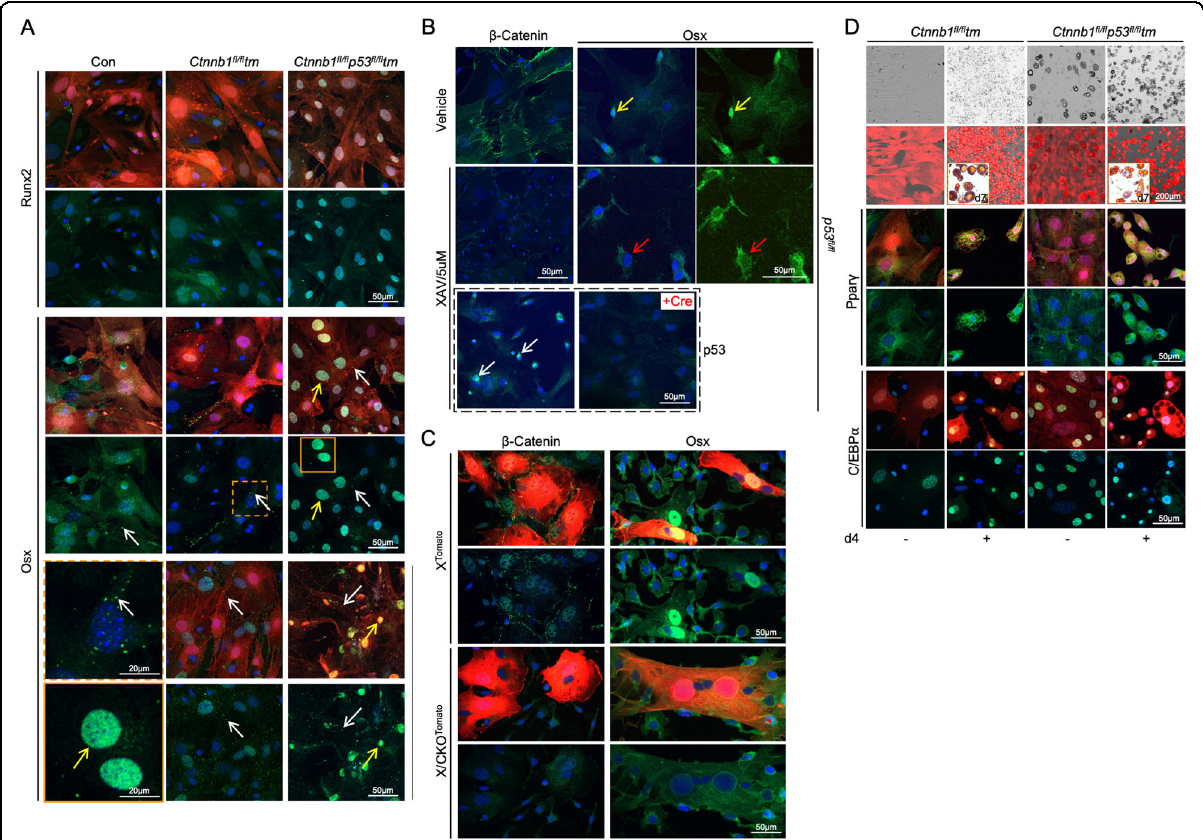
Fig. 5 Elevated p53 in the nuclei of β -catenin – MPCs. A Confocal images of anti-Runx2 and anti-Osx ICC of Ad-Cre-treated MPCs. Con: ROSA26R- Tomato . The images with dotted and solid orange lines at bottom left show magni fi ed areas indicated by corresponding orange squares. Yellow arrows: Osx + nuclei. White arrows: Osx + granules. B MPCs were isolated from p53 fl / fl mice and induced for osteoblastic differentiation for 7 days in the presence of DMSO (vehicle) or XAV939. ICC revealed evident β -catenin and Osx (yellow arrows) signal on vehicle-treated MPCs, whereas XAV939- treated MPCs showed no β -catenin, strong p53 nuclear staining (white arrows), and Osx signal outside of nuclei (red arrows). Only MPCs of the image labeled “ + Cre ” were infected with Ad-Cre. C Anti - β -catenin and anti-Osx staining of control and β -catenin – C-MPCs isolated from 3-week-old X Tomato and X/CKO Tomato mice. D Isolation of MPCs is detailed in Fig. 3A. The Ad-Cre-treated MPCs were cultured with or without adipogenic stimuli. Adipogenic differentiation was evaluated at day 4 by anti-Ppar γ and anti-C/EBP α ICC and at d7 by Oil Red staining shown in the images with yellow outlines. Top two rows of images are taken using EVOS microscope from live